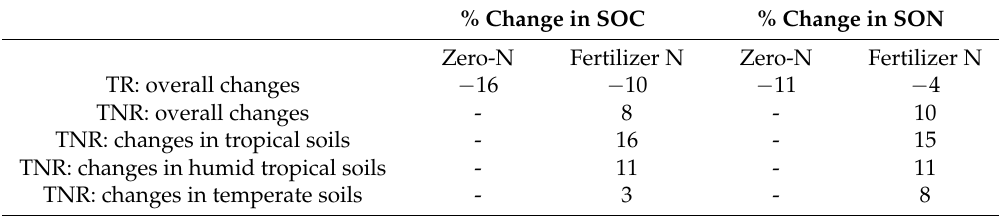
Table 2. Changes in SOC and SON in zero-N and N fertilized plots observed by meta-analysis of data from 114 long-term experiments following time-response ratio (TR) and time by fertilizer N response ratio (TNR). % Change in SOC